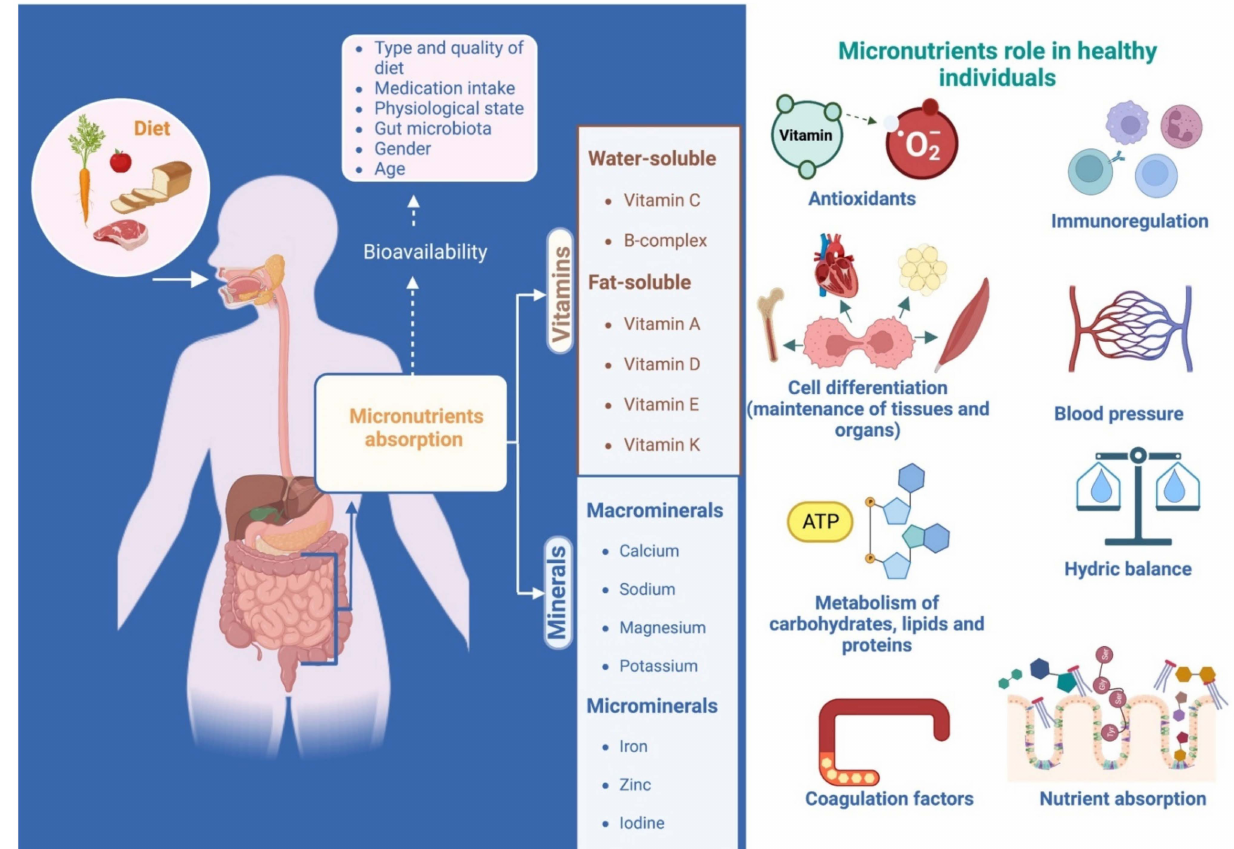
Figure 1. Micronutrients role in healthy individuals. Whether micronutrients’ daily intake re- quirements are grams or as much as micrograms, their presence is critical to several body systems regulations. Their stand-out tasks are oxidation-reduction process modulation, immunoregulation, cell differentiation, water and electrolyte balance, homeostasis in arterial pressure, well-functioning coagulation factors, and the synthesis and absorption of some macronutrients and micronutrients. Its bioavailability, absorption, and synthesis rely on factors such as age, gender, diet, GM, pharmaceutical prescriptions, and pre-existing metabolic or pathological conditions (created with